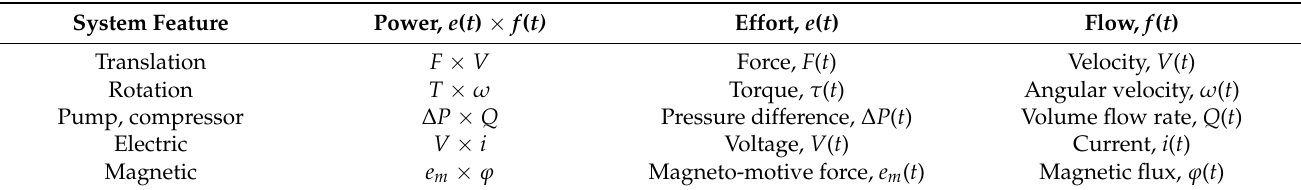
Table 2. Power stated as effort and flow in an energy transport